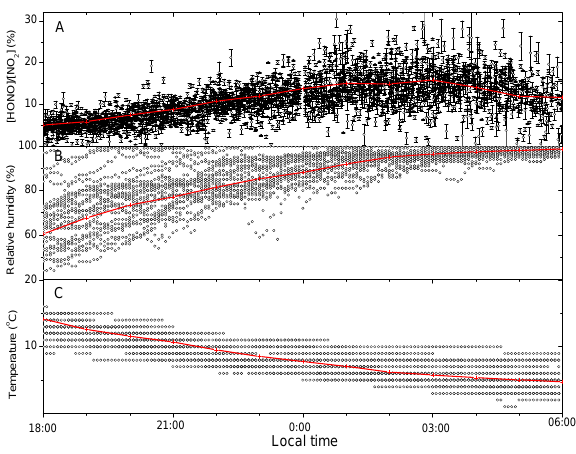
Fig. 7. Normalized HONO formation rate constants decrease with Figure 7. Normalized HONO formation rate constants decrease with the increasing RH. Red the increasing RH. Red open circles are individual HONO forma- Fig. 6. [HONO]/[NO 2 ], relative humidity, and temperature in the open circles are individual HONO formation values of each night. Black dots are average tion values of each night. Black dots are average values of HONO nocturnal Kathmandu atmosphere during the whole observation pe- values of HONO formation in RH range of 65-75%, 75-85%, 85-95% and 95%-100%. Error formation in RH range of 65–75%, 75–85%, 85–95% and 95– riod. Lines with plus marks show average values. bars are the standard deviations. 100%. Error bars are the standard